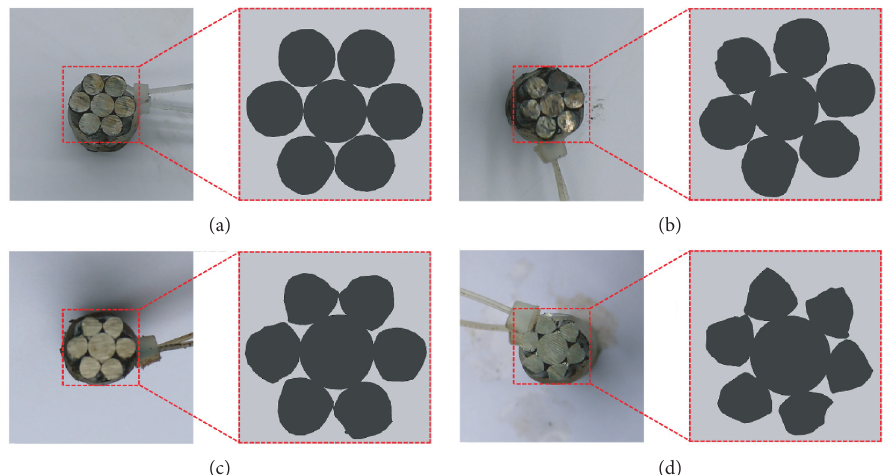
Figure 6: Cross section of corroded samples. (a) corrosion rate 11.57%, (b) corrosion rate 22.12%, (c) corrosion rate 35.84%, and (d) corrosion rate